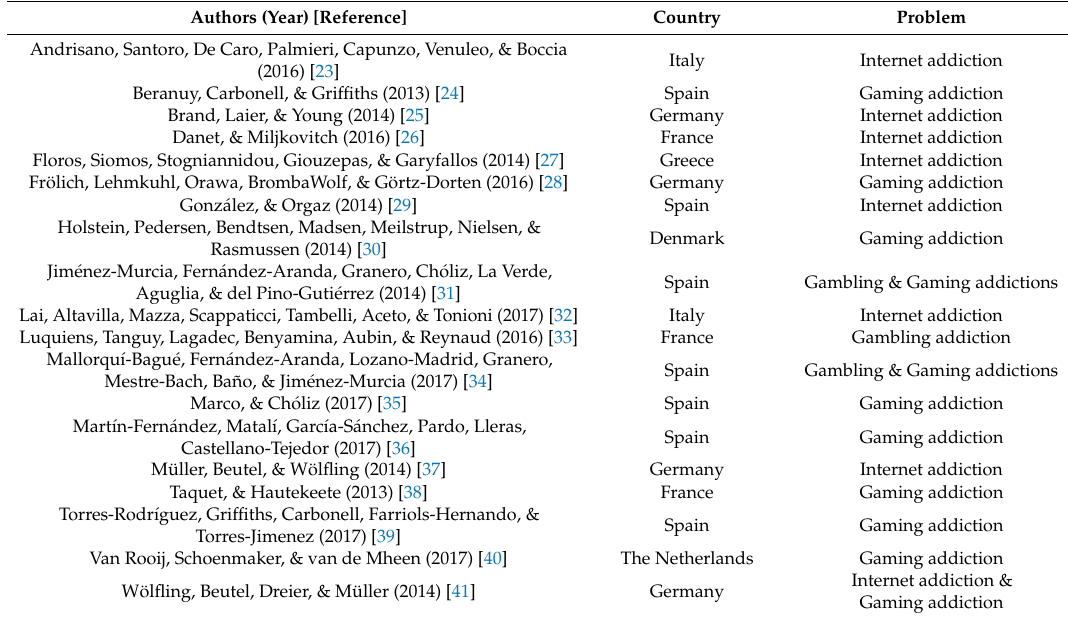
Table 1. Papers selected for the review ( N =